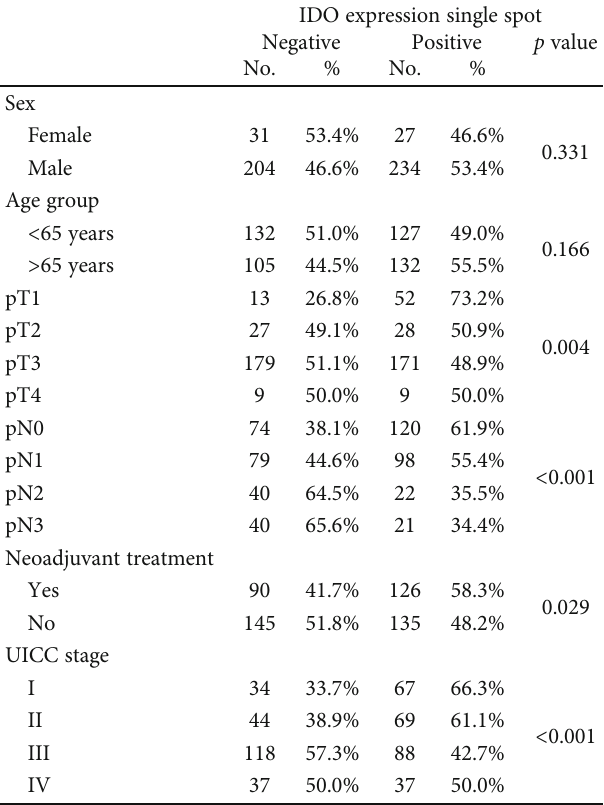
Table 2: Patient characteristics of the entire cohort, IDO expression results ( n = 551 ; 496 patients analyzable).